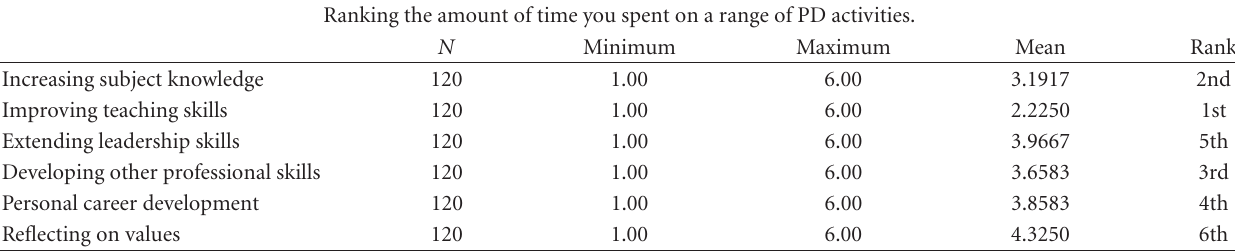
Table 9: The amount of time teachers spent on a range of PD activities. Ranking the amount of time you spent on a range of PD activities.